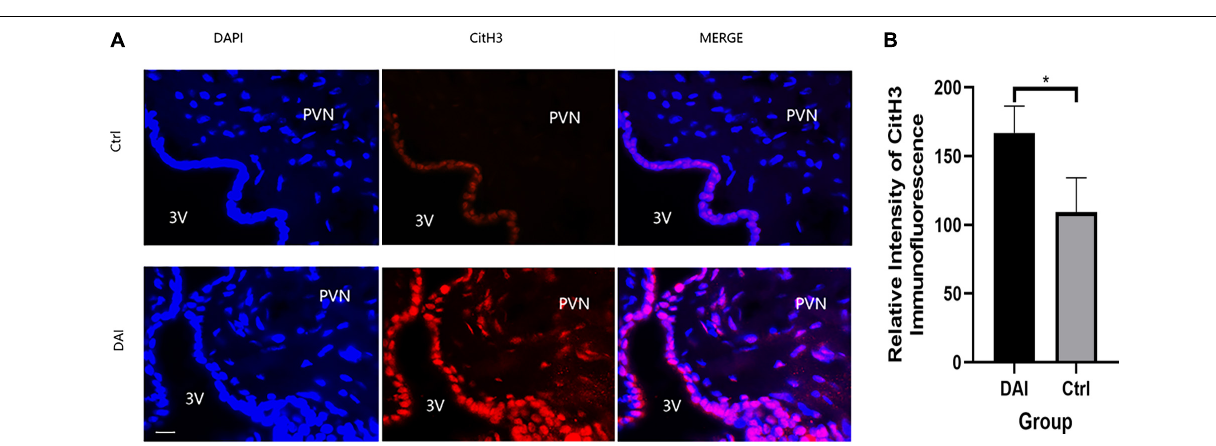
FIGURE 4 | (A) Immunofluorescence detection of Citrullinated histone H3 (CitH3) expression in the paraventricular nucleus (PVN) of rats 72 h after DAI; red fluorescent (CitH3) and blue fluorescent, 4 (cid:48) ,6-diamidino-2-phenylindole (DAPI) were used to label the tissues in the PVN, 3V (ventriculus tertius) was used to represent the third ventricle of rats; 50 µ m scale bar shown. Grouping: DAI group ( n = 10) and control group ( n = 6). (B) There was a significant difference in CitH3 fluorescence intensity between the DAI and control groups (* P <